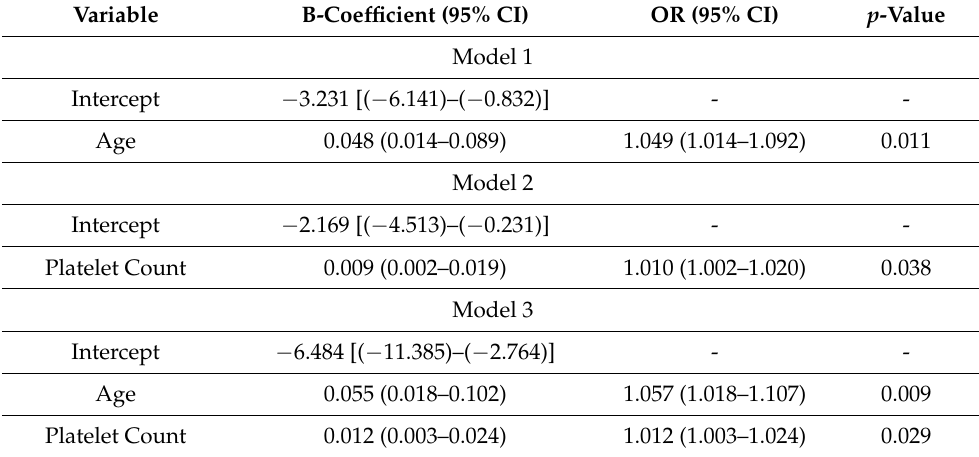
Table 3. Results of the predictive